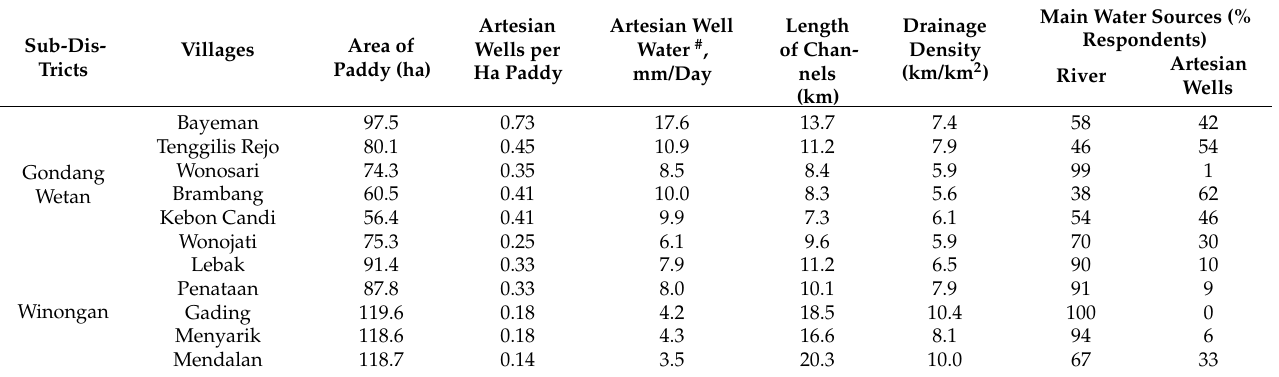
Table 4. Distribution of area of paddy field (ha), the area with crop rotation (ha), number of artesian wells, and drainage density (km/km 2 ) in each village in two sub-districts.